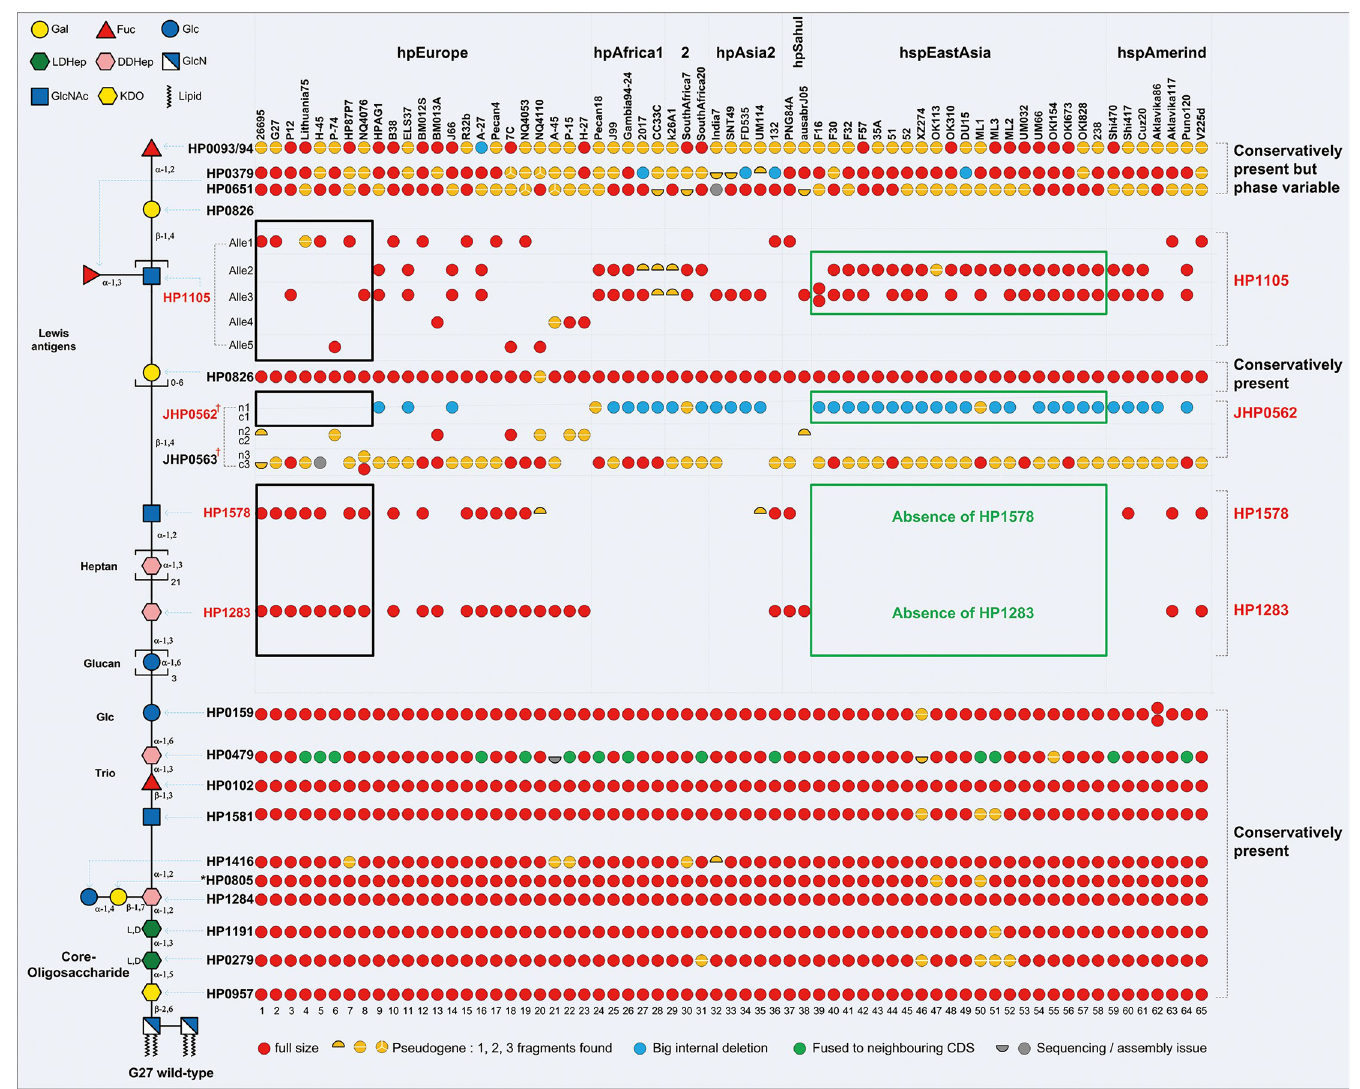
Fig 4. Bioinformatic analysis of the glycosyltransferase genes in H . pylori LPS biosynthetic pathway. The pattern of the presence/absence of the assigned LPS glycosyltransferase genes in 65 strains with well-assembled LPS genes. Based on the polymorphism of the carboxy-terminal half of the enzyme, 5 HP1105 alleles are distinguished. The locus JHP0562-0563 contains one or two glycosyltransferase genes among the three possible ones (1 to 3) with the amino-terminal modules (n1 to n3) and the carboxy-terminal counterparts (c1 to c3). The glycosyltransferases responsible for synthesis of core-Trio-Glc and distal Lewis antigens are conserved amongst H . pylori strains; the glycosyltransferases responsible for synthesis of the intervening region between the core-Trio-Glc and the distal Lewis antigens vary substantially among H . pylori populations: both HP1283 and HP1578 are absent in all studied hspEastAsia strains exhibiting JHP0562 (n1c1) and two copies of HP1105 alleles (highlighted in green box). In contrast, strains harbouring the HP1283/HP1578 usually contain only one copy of HP1105 (mostly allele 1) and lack JHP0562 (n1c1) (highlighted in black